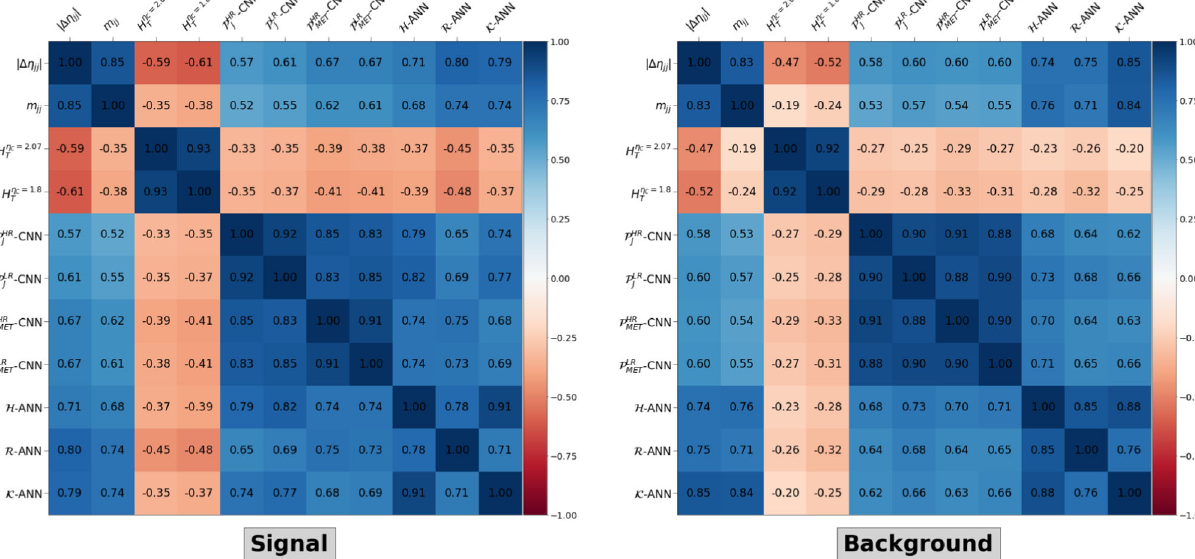
Fig. 14 Pearson’s correlation coefficients amongst the first four high-level variables with highest separation and the network-outputs for (left) signal and (right) background. These have been calculated using the validation